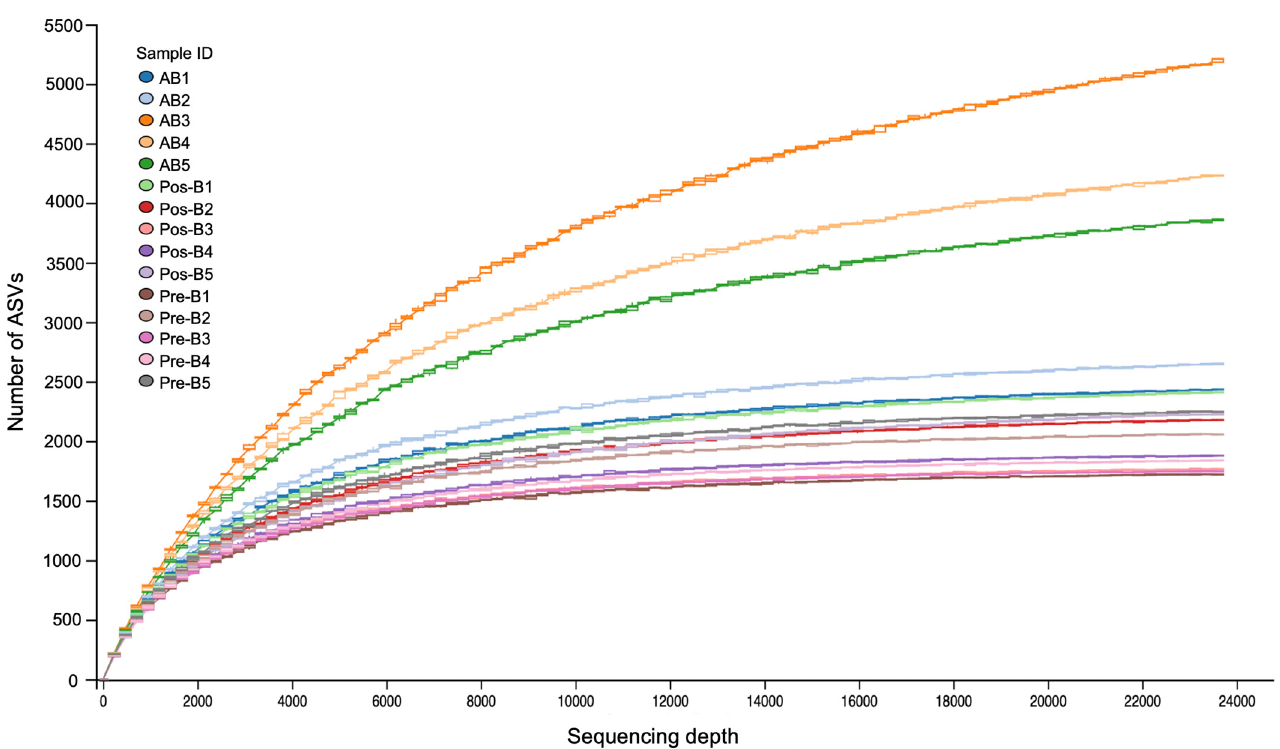
Figure 3. Rarefaction curves of all samples in rice fields at preburning (pre-B), postburning (pos-B), Figure 3 . Rarefaction curves of all samples in rice fields at preburning ( pre - B ) , postburning ( pos - B ) , and 1 year after burning and 1 year after burning ( AB ).